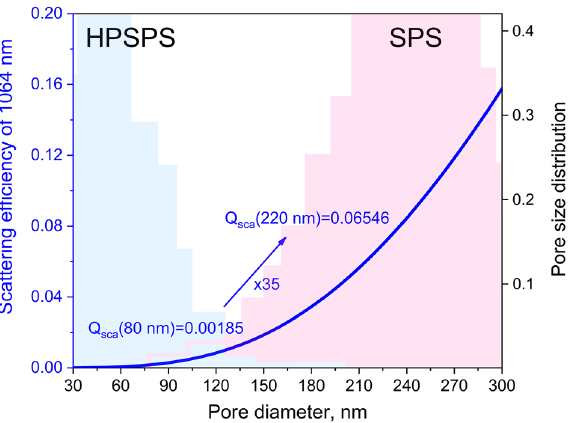
Figure 7. Scattering efficiency as a function of pore diameter calculated using MiePlot 68 , the shaded light blue area represents the pore size distribution in HPSPS samples (gamma distribution according to 69 ) and the shaded pink area represents the same for SPS samples. It is possible to see the scattering efficiency is 35 times higher for average pores in the SPS samples compared to those is